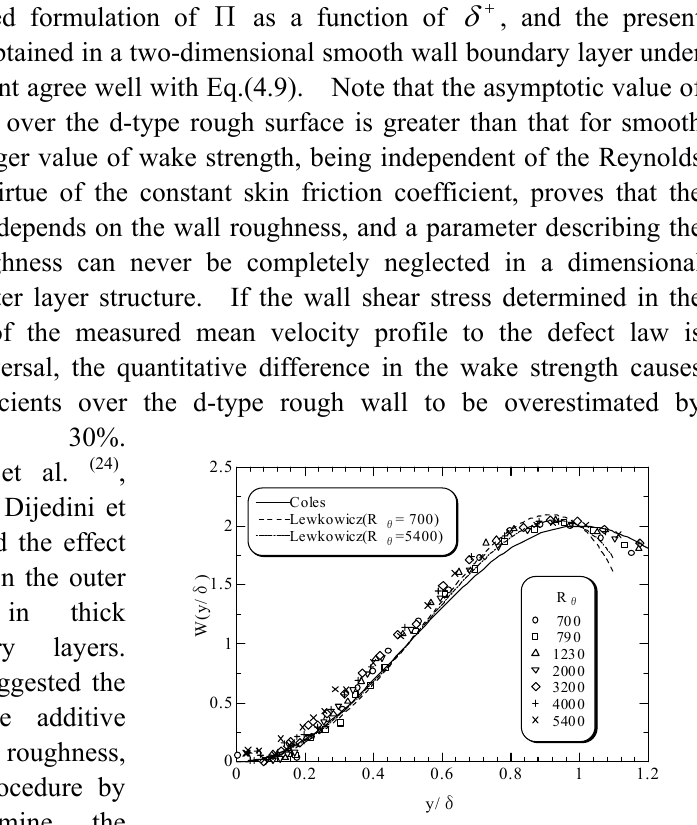
Fig.7 Wake functions of the d-type rough wall boundary layer.